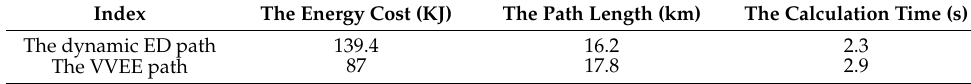
Figure 17. Comparison between the dynamic ED path and the VVEE path. Table 11. Comparison between the dynamic ED path and the VVEE